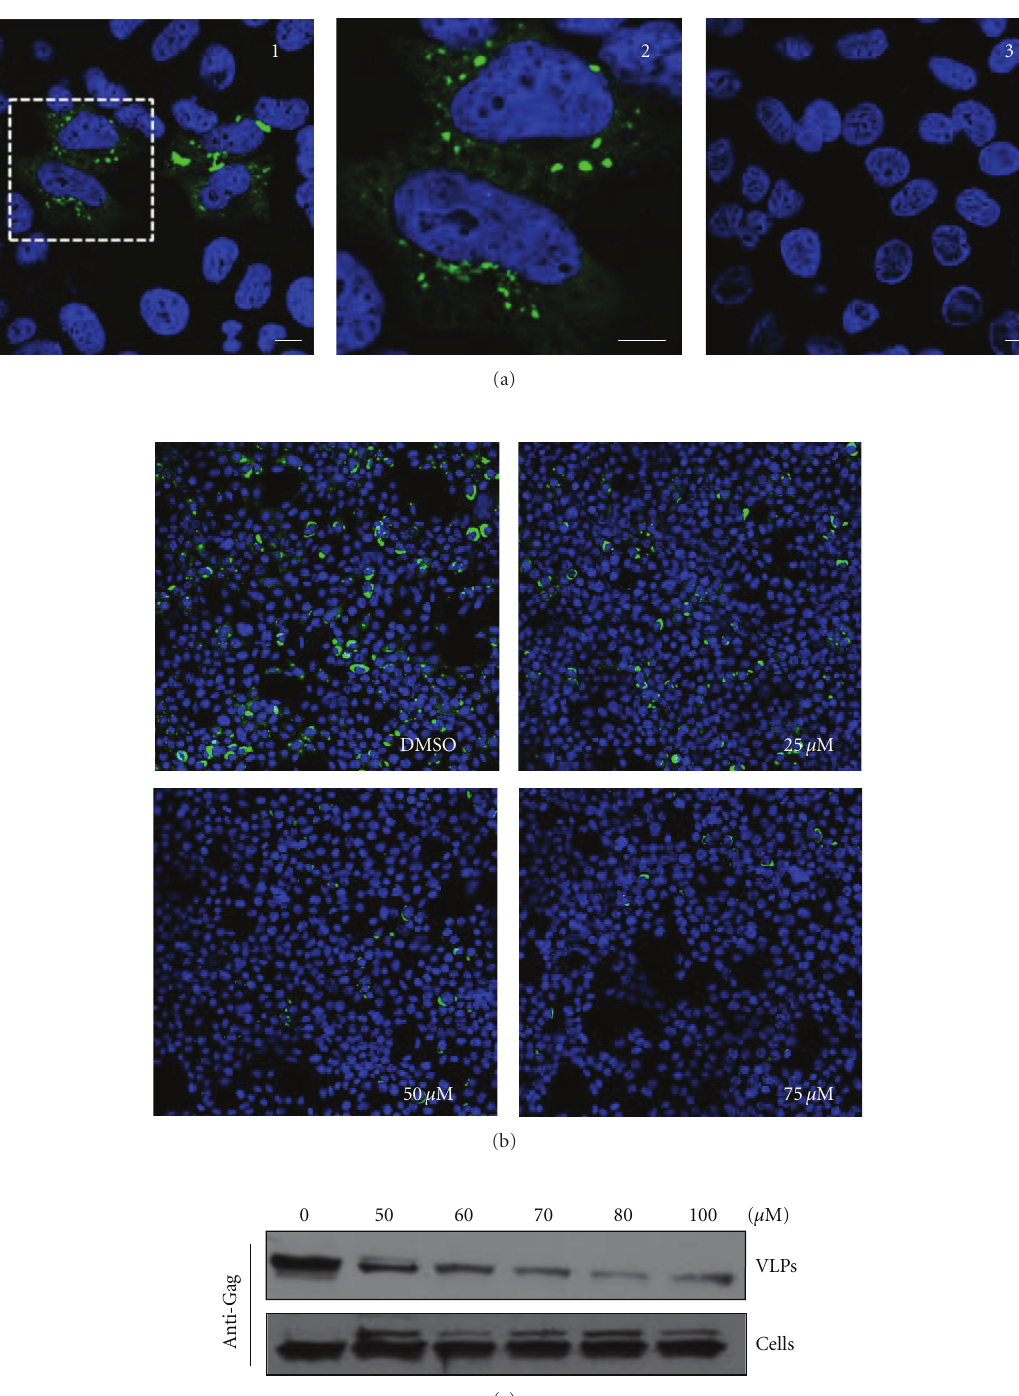
Figure 5: Inhibition of HIV-1 Gag-Tsg101 interaction and VLP budding. (a) Human 293T cells grown on coverslips in 6-well plates were transfected with NYFP-Tsg101 + CYFP-Gag-WT (panels 1 and 2) or NYFP-Tsg101 + CYFP-Gag- Δ P6 (panel 3). Cells were washed, fixed, and examined for YFP fluorescence by confocal microscopy at 24 hours p.t. The image within the dotted square in panel 1 was enlarged and shown panel 2. (b) Human 293T cells grown on coverslips in 6-well plates were transfected with NYFP-Tsg101 + CYFP-Gag-WT in the presence of DMSO alone, or 25, 50, or 75 µ M of compound 5539-0062 as indicated. Cells were washed, fixed, and examined for YFP fluorescence by confocal microscopy at 24hours p.t. (c) Standard budding assay and western blotting for Gag in VLPs and cell extracts from human 293T cells treated with DMSO alone, or the indicated concentrations of PTAP-inhibitor